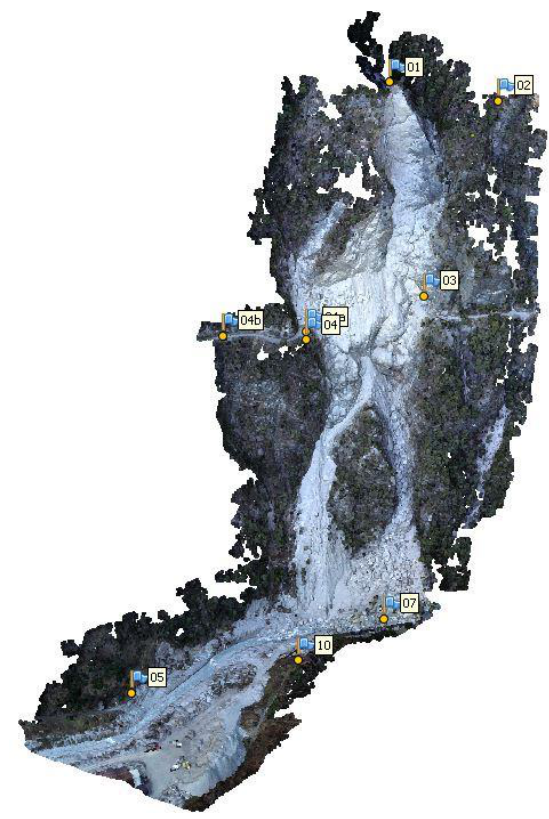
Figure 10. Distribution of GCPs (shown on the dense point cloud).